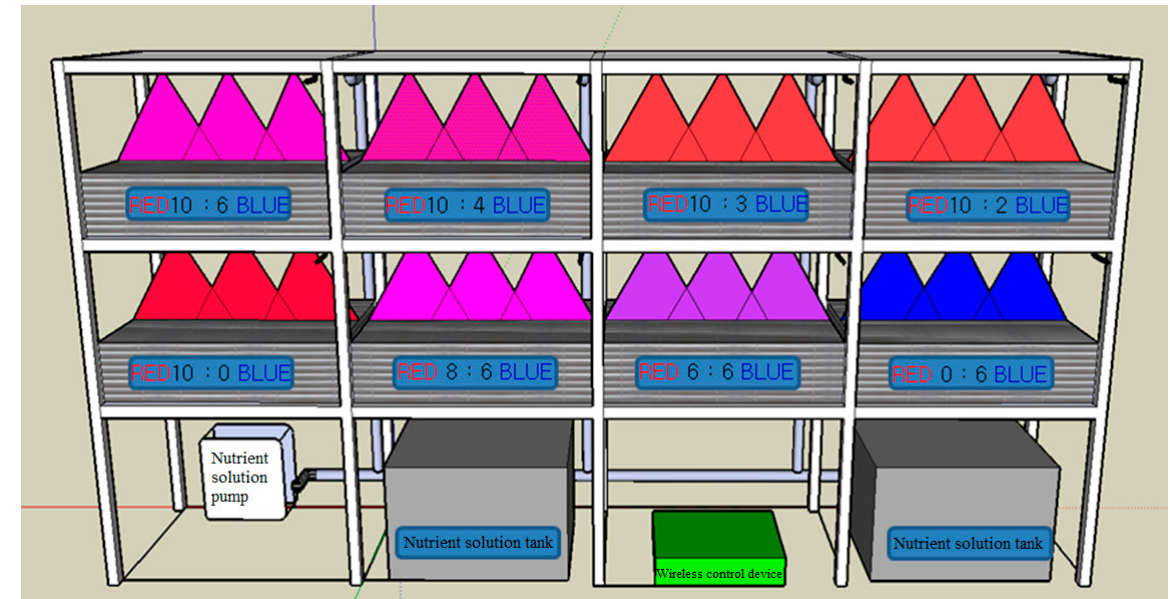
Figure 15. The design of cultivation test group for environmental control and monitoring.